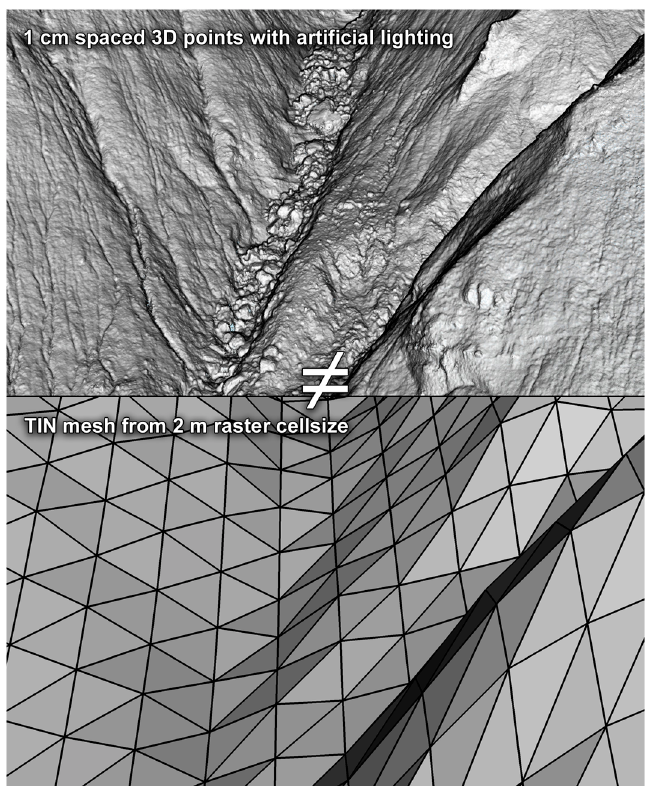
Figure 1. Surface roughness is frequently lost when representing a site with a digital terrain model. On the lower image, most of the surface roughness is absent on the triangulated mesh from a gridded DTM raster with a 2 m cell size when compared to the same view with a 1 cm spaced 3D point cloud (upper image).